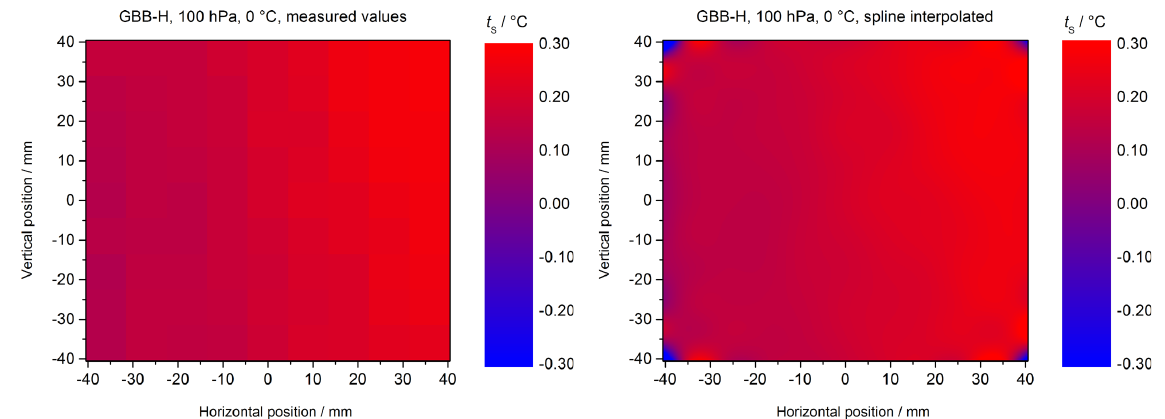
Fig. 17. The spatial distribution of the radiation temperature of the GLORIA blackbody GBB-H at a nominal temperature of 0 ◦ C and 100 hPa. The field-of-view is 82 mm × 82 mm. The measured data is shown on the left panel, the spline interpolated data on the right. The homogeneity is 47 mK (standard deviation).